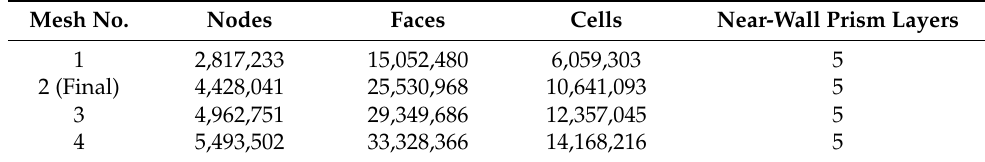
Table 1. Details of the meshes used for the independence test. Mesh